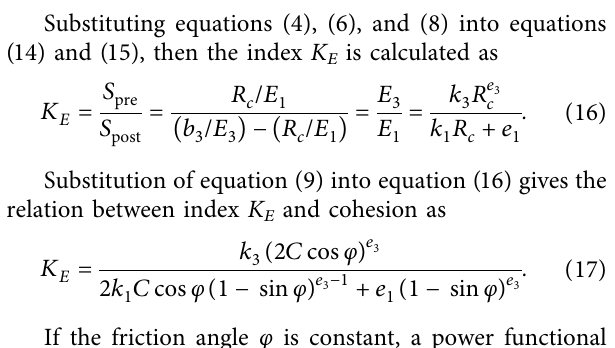
Figure 7: The relationship between bursting proneness indices and cohesion: (a) Index R and postpeak